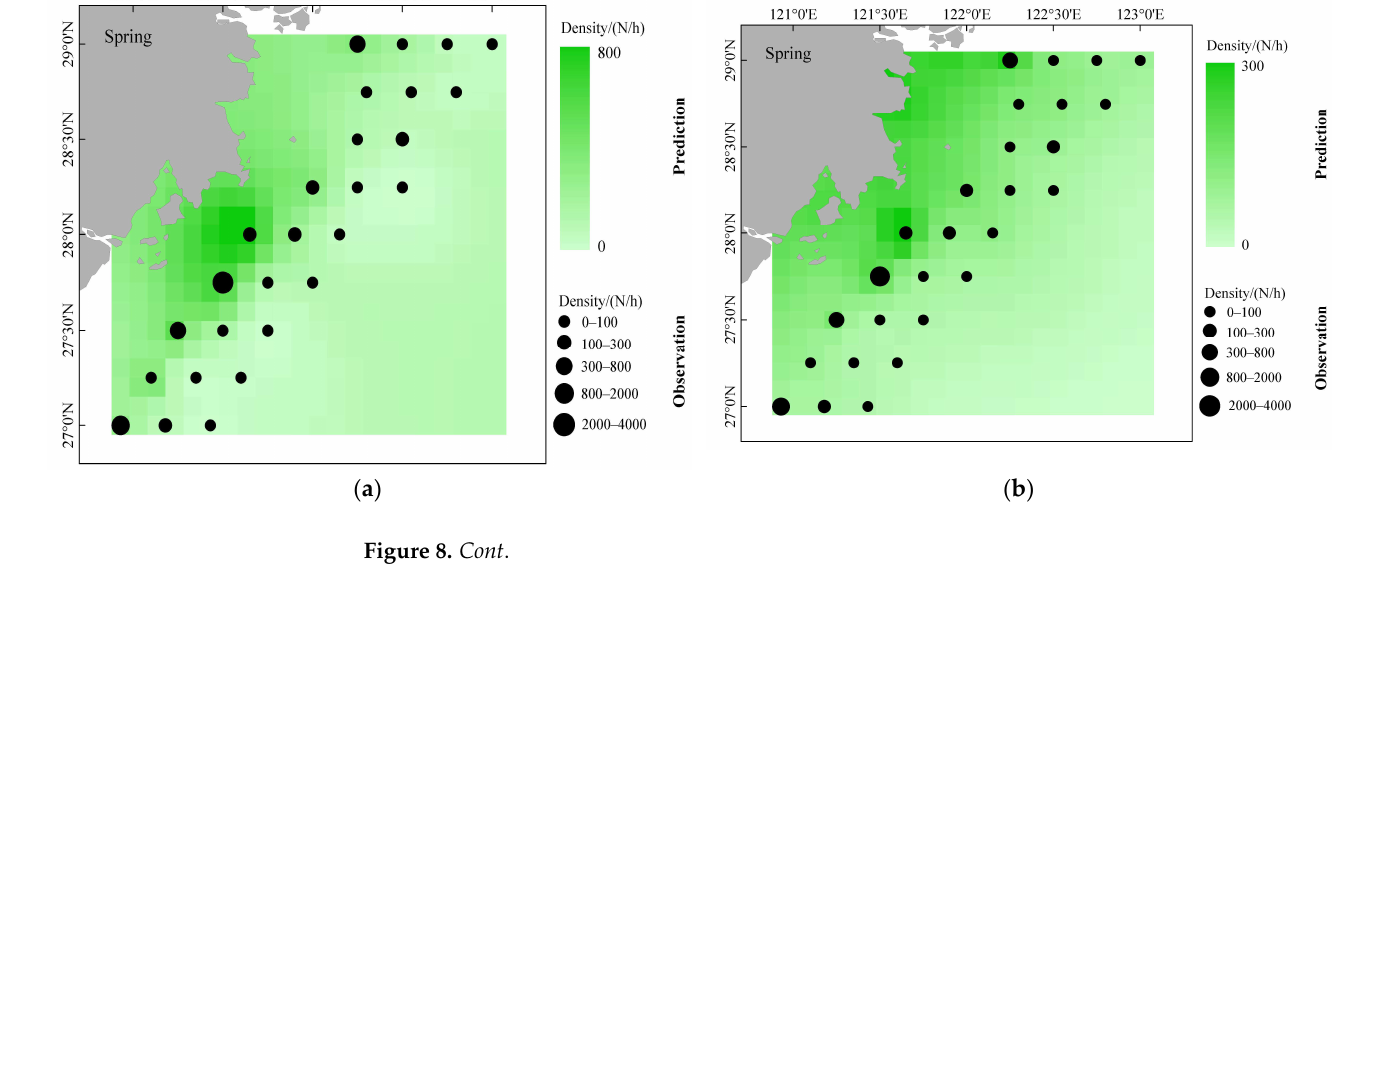
Figure 7. Scatter plots of observed and predicted densities of D. maruadsi in Yearly-GAM. ( a ) spring; ( b ) summer; ( c ) autumn; ( d ) whole year.